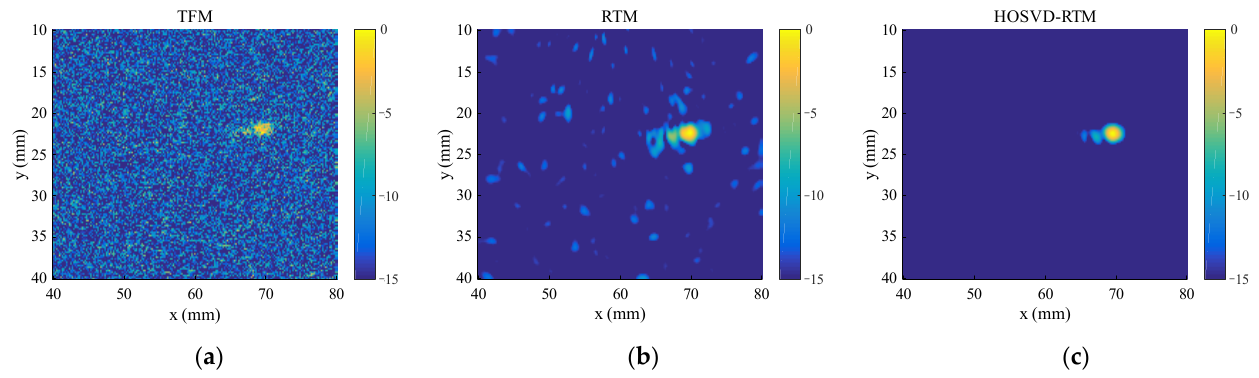
Figure 6. Simulated signal imaging results obtained with various algorithms. ( a ) TFM; ( b ) RTM; ( c ) HOSVD-RTM.